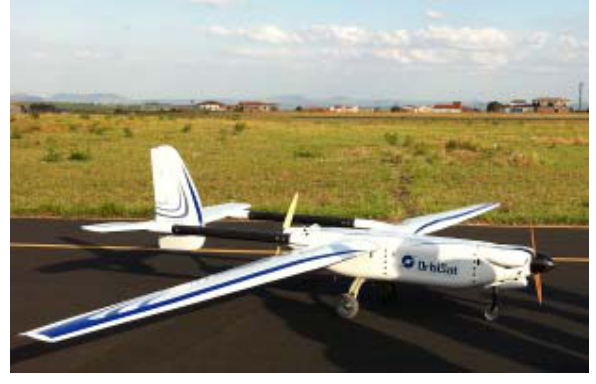
Figure 1: The SARVANT aerial